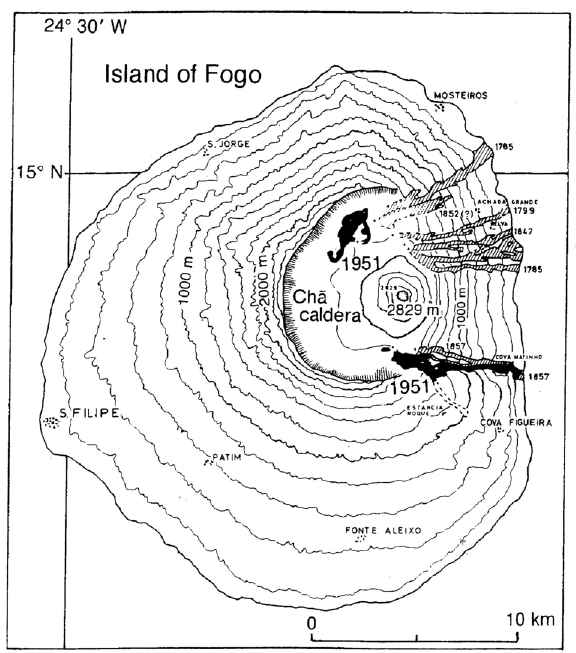
Figure 11. Twin parasitic vents formed in the 1951 eruption of Fogo volcano after Machado [1962].